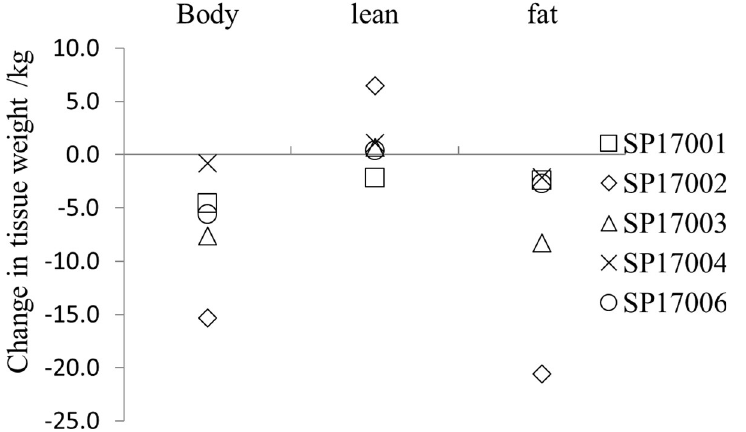
Fig 3. The change in body composition